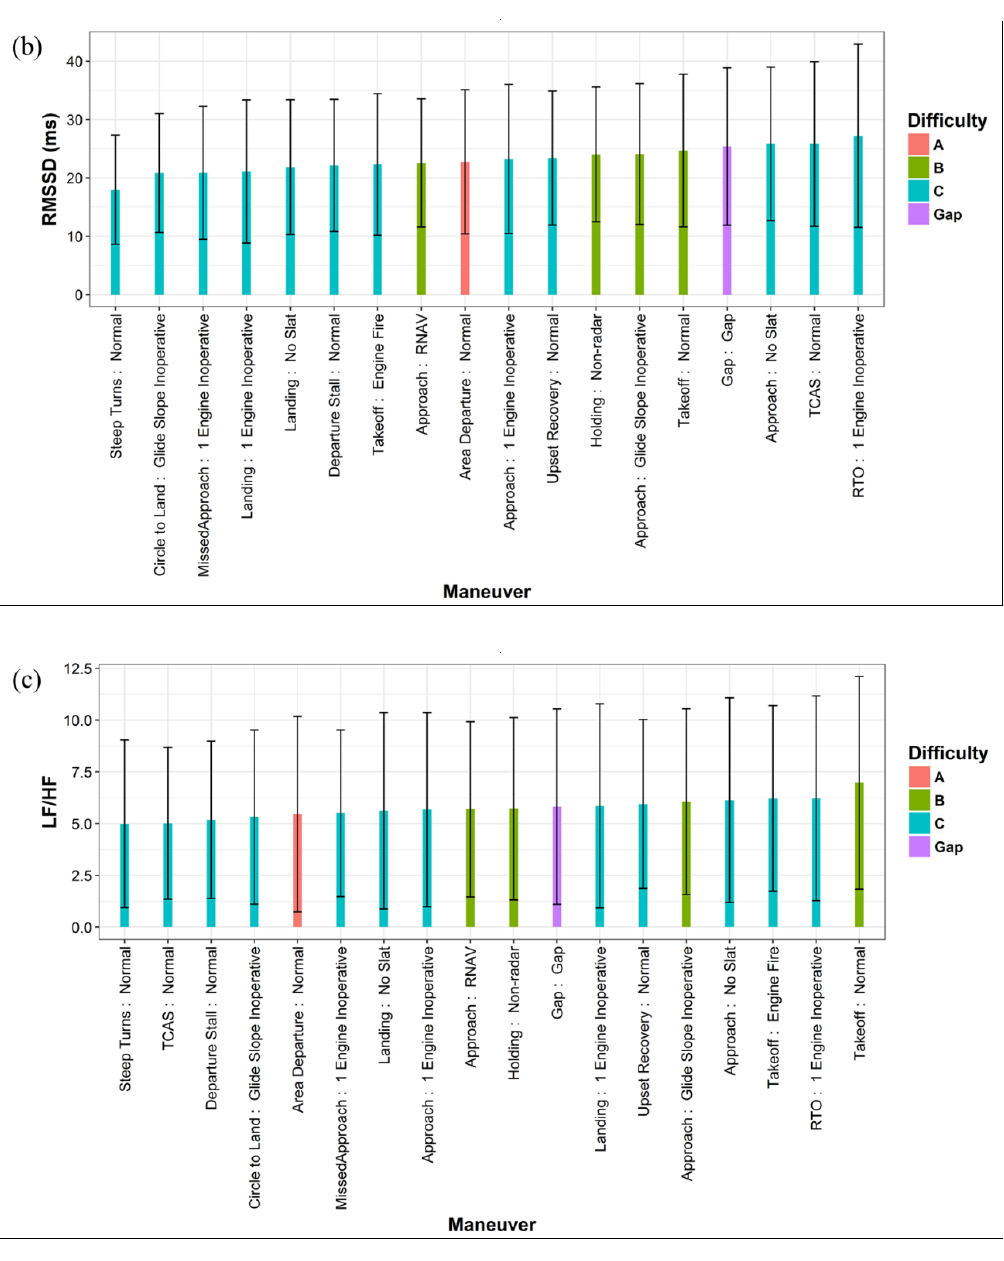
Figure 2. Average HRV values by flight maneuver types and difficulty (the error bars represent the standard deviations): ( a ) SDNN; ( b ) RMSSD; ( c ) LF/HF.